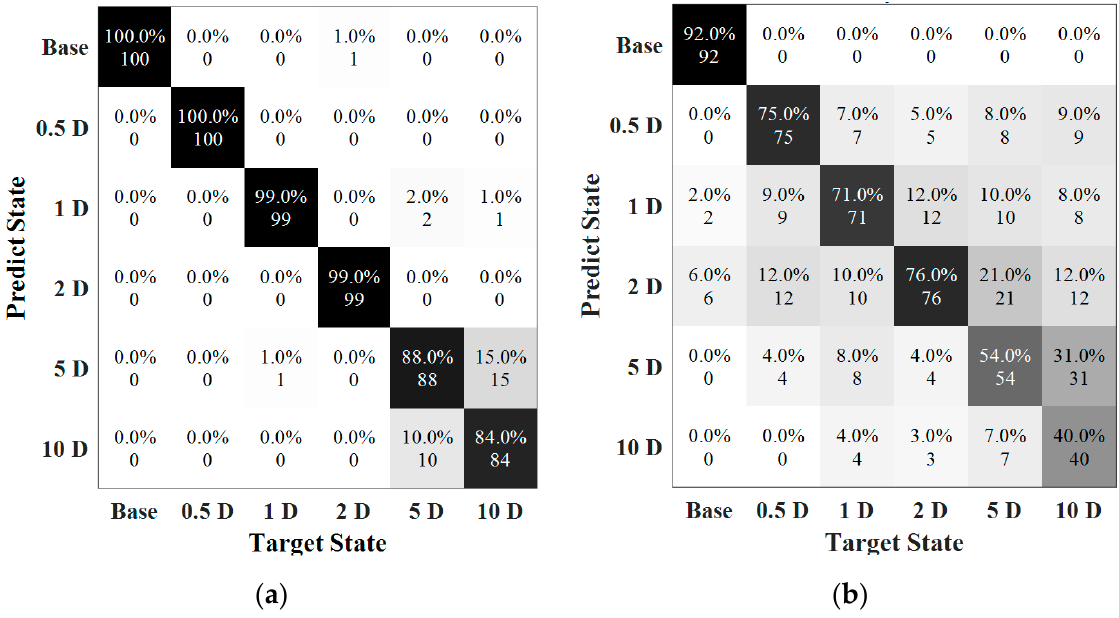
Figure 21. Testing results. ( a ) SNR = 70 dB (Accuracy = 95%). ( b ) SNR = 60 dB (Accuracy = 68%).